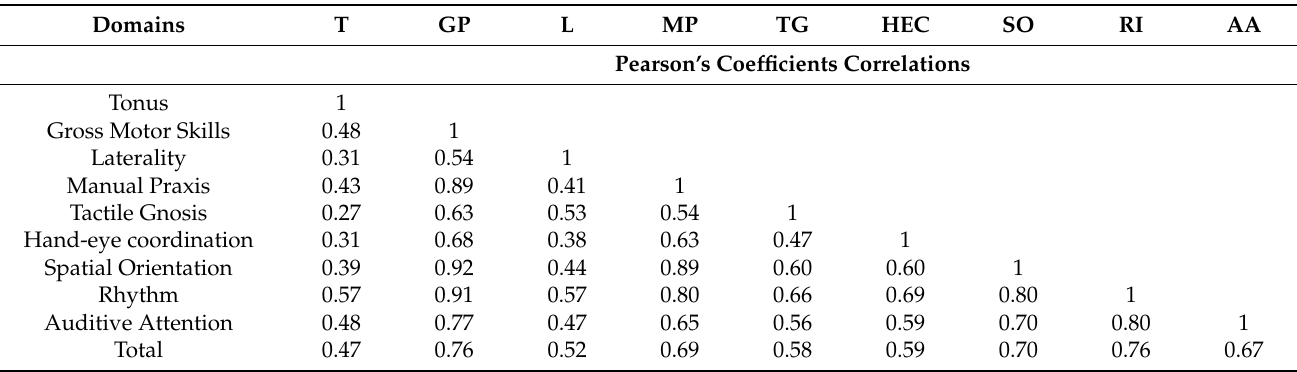
Table 5. NPmot.pt domains’s intercorrelations ( n =